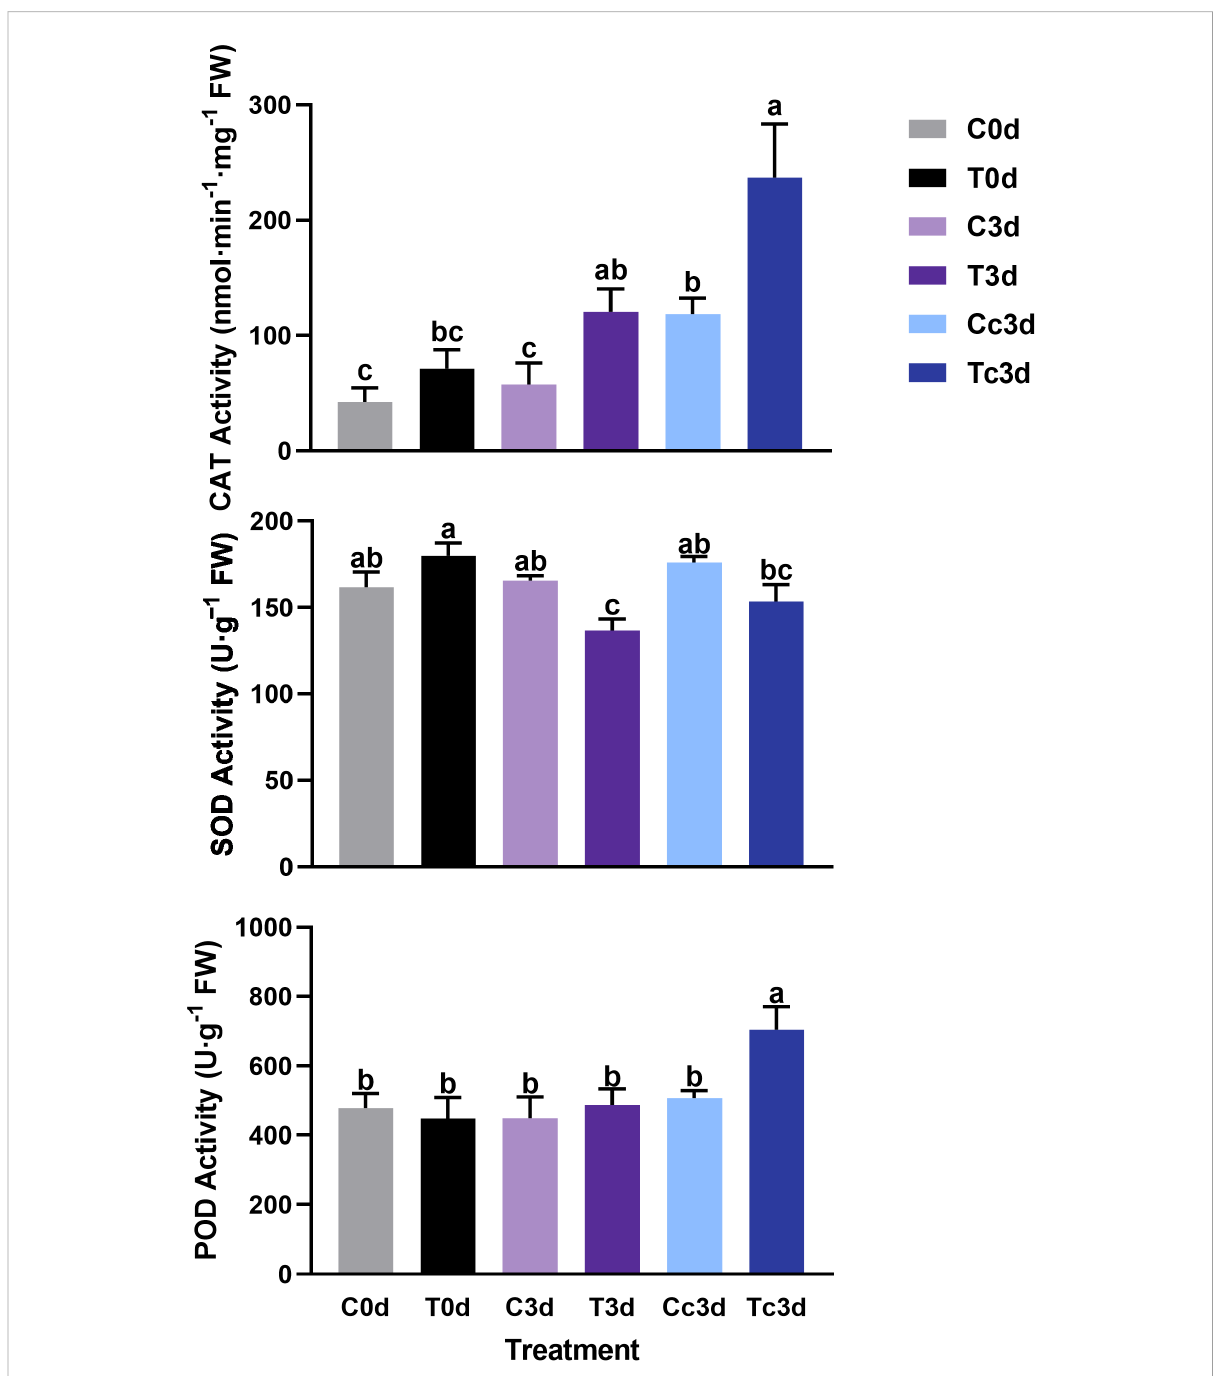
FIGURE 3 The effect of arbuscular mycorrhizal fungus and anthracnose pathogen on the activities of antioxidant enzymes. CAT: catalase; SOD: superoxide dismutase; POD: peroxidase. “ C, ” “ d, ” “ T, ” and “ c ” indicated “ non-mycorrhizal, ” “ days post infection, ” “ mycorrhizal, ” and “ Colletotrichum camelliae , ” respectively. In each column means with similar letters are not signi fi cantly different at p <